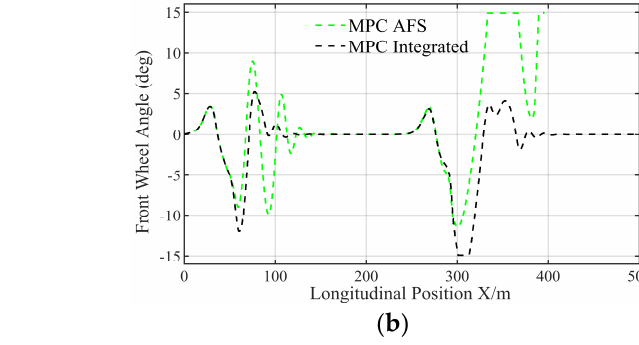
Figure 9. Comparison of ( a ) heading angle and ( b ) front wheel angle at lower speed ( V x = 80km/h).